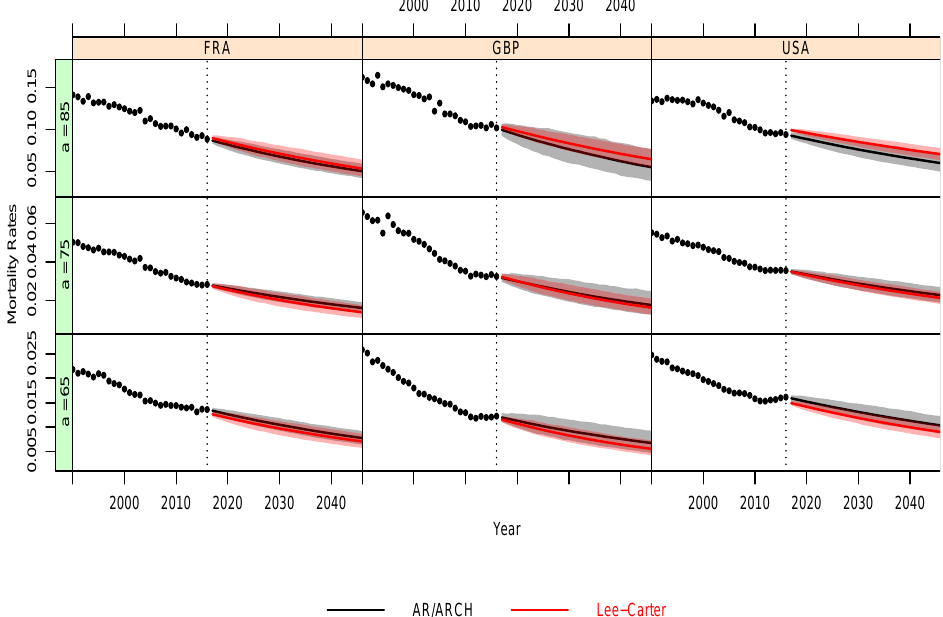
Figure 6. Mortality rates: Forecast mortality rates at age 65, 75, and 85 for France, England and Wales, and US populations produced by both the selected AR-ARCH (black) model and Lee–Carter (red) model. The 95% prediction intervals are also